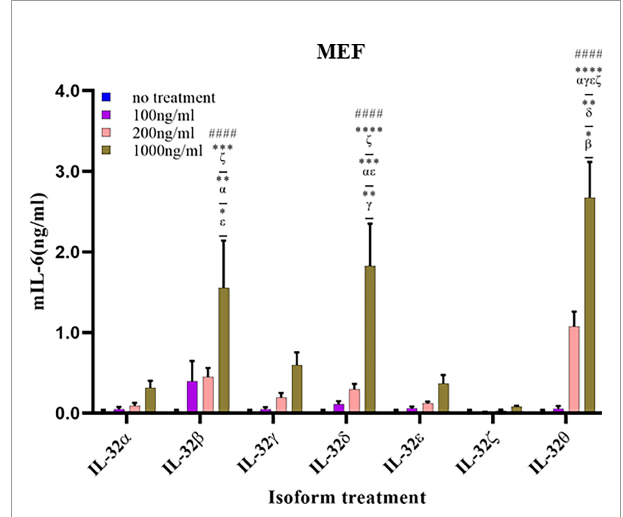
FIGURE 7 | Biological activities of seven rIL-32 isoforms in mouse embryonic fi broblast. rIL-32 isoforms with different concentrations were treated for 18 h. The bar graph represents the level of IL-6 production, mean ± SEM, measured by ELISA. Statistical testing was performed using two-way ANOVA, followed by Tukey ’ s post-hoc analysis. #### p < 0.0001 as compared to no-treatment control within the same isoform treatment. * p < 0.05, ** p < 0.01, *** p < 0.001, **** p < 0.0001 as compared to other displayed isoform symbols treated with the same concentration.